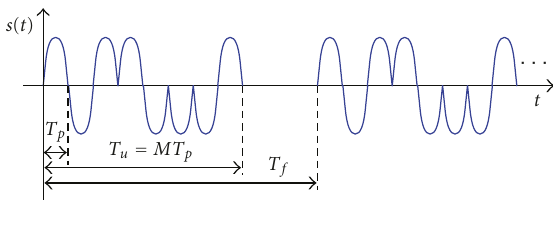
Figure 2: Sounding sequence s ( t